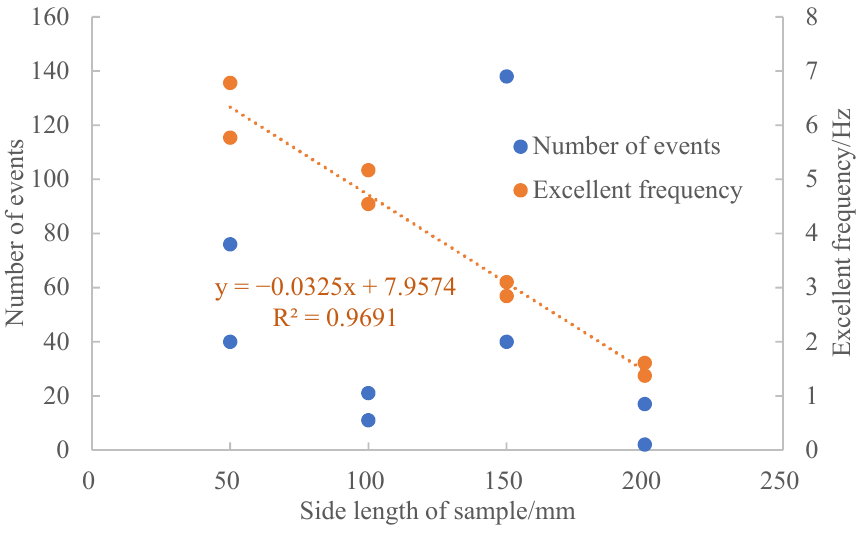
Figure 9. Number of infrasound events and average excellent frequency of samples with different sizes.